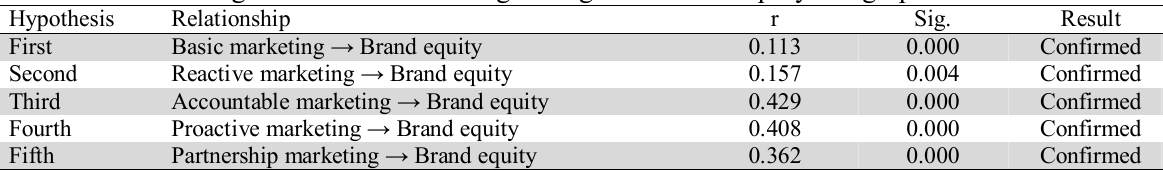
The results of testing the effect of marketing strategies on brand equity using Spearman correlation Hypothesis Relationship r Sig.